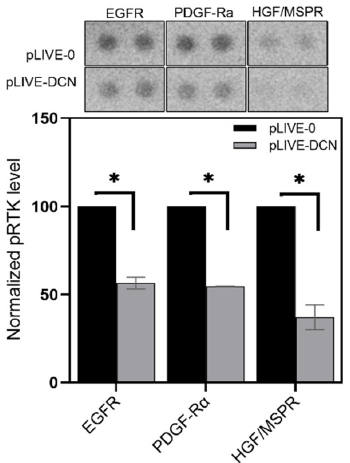
Figure 5. Phosphorylation of epidermal growth factor receptor (EGFR), MSPR and PDGFRα receptors in mock-transfected vs. DCN-transfected livers. Overexpression of decorin reduced the levels of active receptor tyrosine kinases (RTKs) in the DCN-transfected group. Data are shown as mean ± SD. * p value <